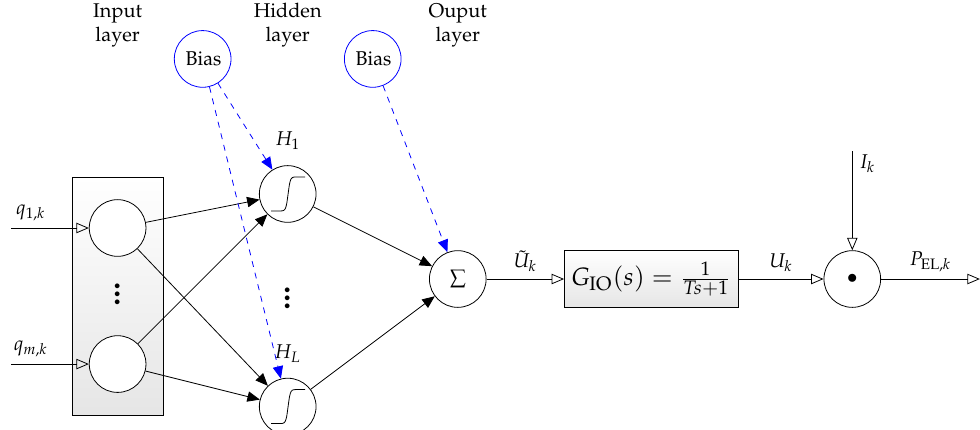
Figure 7. Hammerstein-type dynamic model for the electric power characteristic of the SOFC stack with integer-order dynamics with the network inputs ϑ m, ( 1,1,1 ) , k , ϑ m, ( 1,3,1 ) , k , I k , ϑ CG,m, k , ˙ m N ϑ AG,m, k and the output ˜ U k